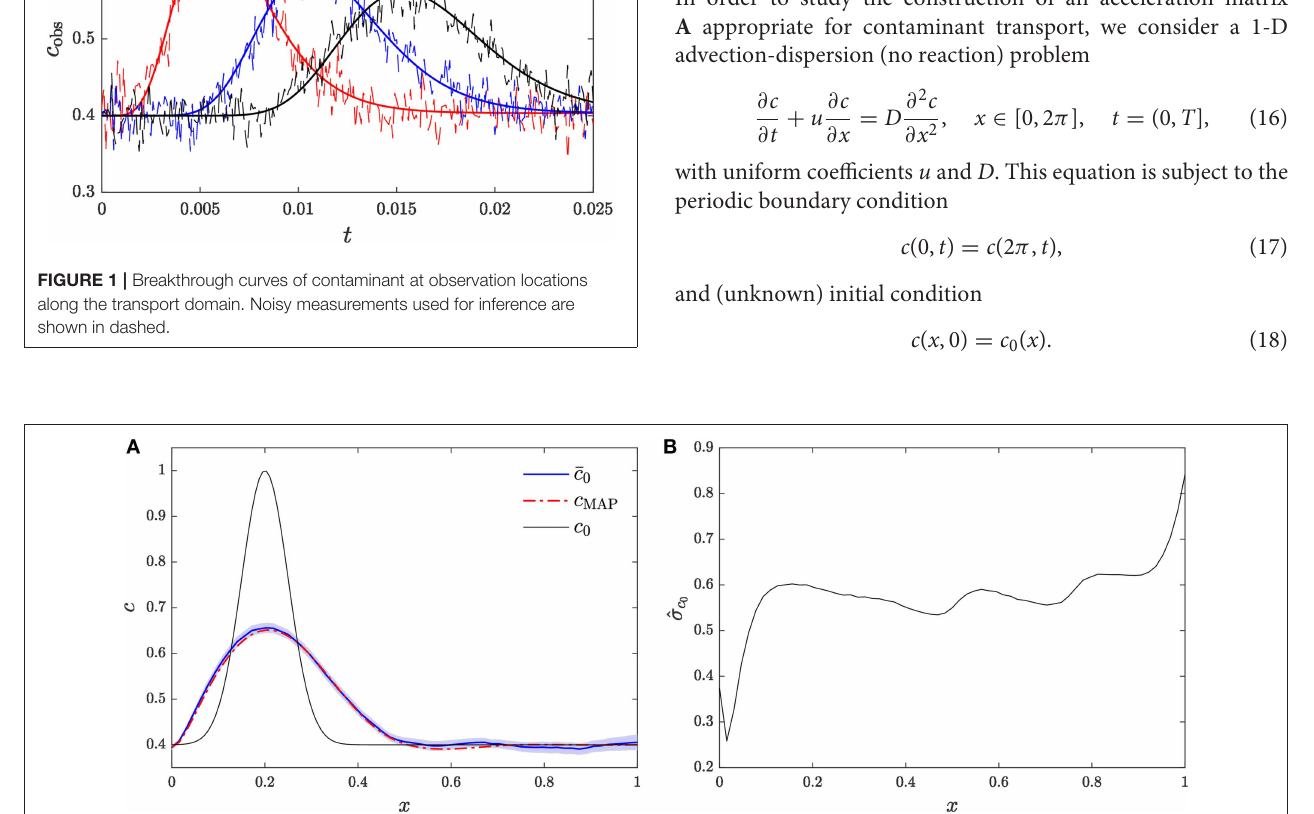
FIGURE 2 | Reconstruction of release profile via HMC. (A) Posterior mean standard deviation.